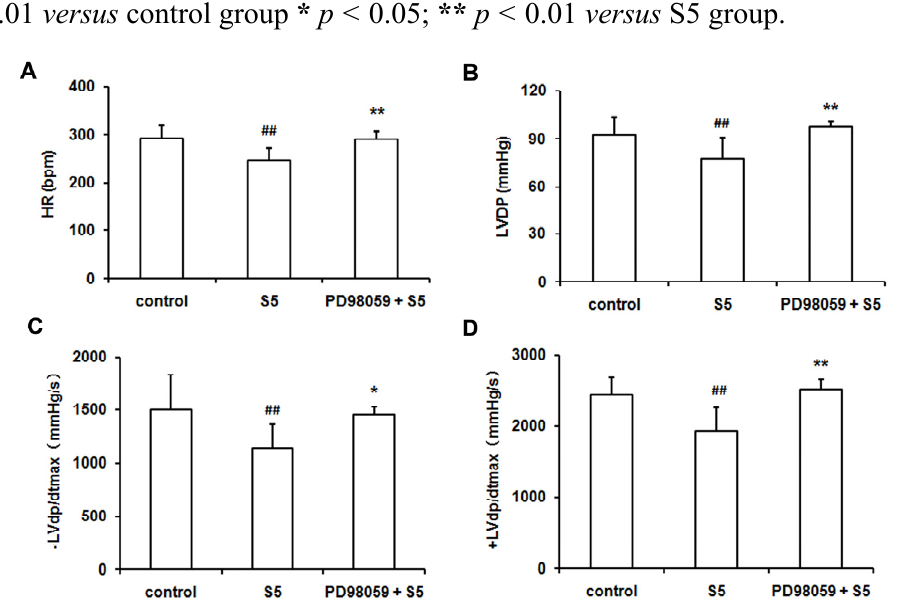
( C ) and +LVd p /d t ( D ) in the max max donor depressed the 2 donor. 2